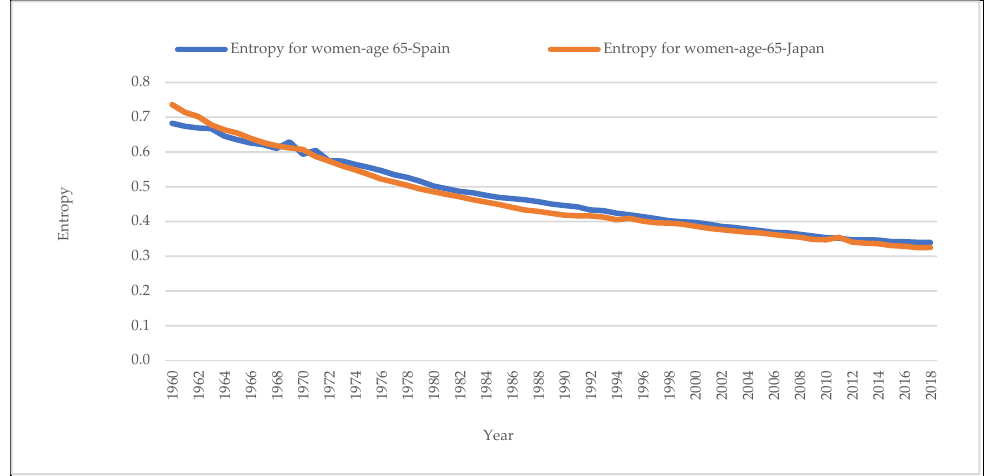
Figure 11. Entropy evolution of the female population at 65 over calendar years . Source: authors.